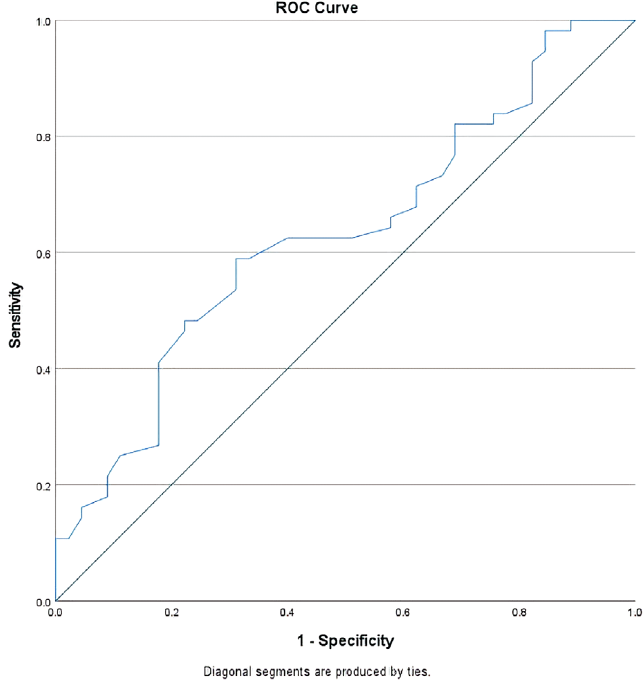
Figure 2. ROC curve of nadir leukocyte levels and CR occurrence during treatment evaluation. Diagonal segments are produced by